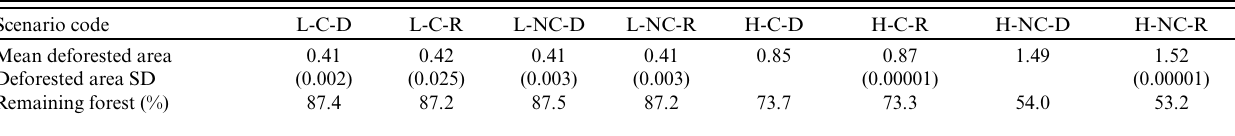
Table 2. Deforested area across scenarios (in Mha) and percentage of remaining forest compared with forest extent in 2015. Scenarios differ in deforestation rate (L: low, H: high), spatial planning at the regional level (C: with corridors, NC: without corridors), and spatial planning at the plot level (D: design, R: random)